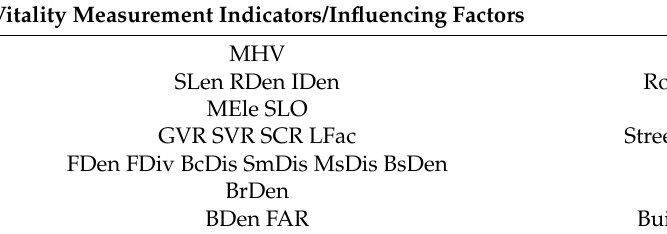
Figure 1. Research scope.